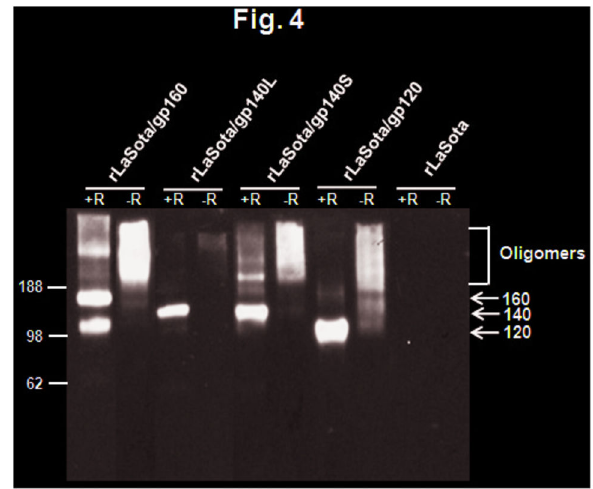
Figure 4. Oligomeric status of NDV-expressed Env proteins. DF1 cells were infected with indicated viruses at an MOI of 0.01 PFU. After 48 h, the cells were collected and cross-linked with DSP and subjected to SDS-PAGE under reducing (+R) or non-reducing (-R) conditions. The gels were analyzed by Western blotting using a pool of gp120-specific monoclonal antibodies. The positions of HIV-1 gp160, gp140 precursor gp120 are indicated by arrows in the right margin. Molecular masses of marker proteins (in kilodaltons) are shown in the left